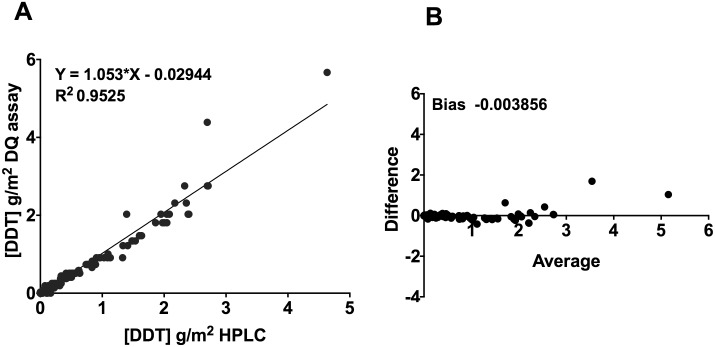
Comparison of DDT quantification of field samples (pooled).A. Bostik sample correlation of IQK vs HPLC; R2 = 0.9525, and B. Bland Altman bias, -0.003856.